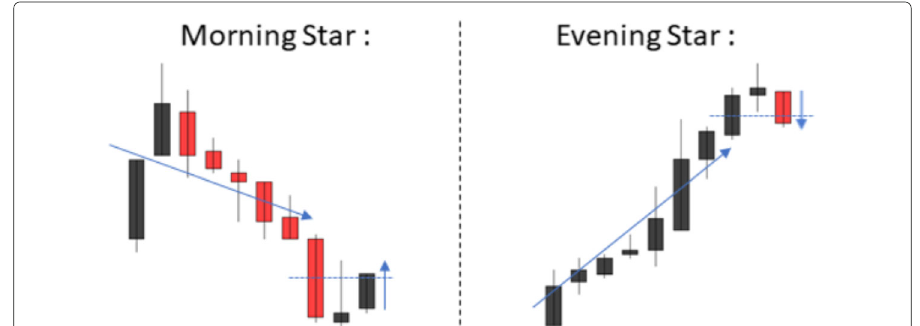
the Convolutional Neural Networks (CNN) model. In the first step, we encode time series data based on opening, high, low, and closing prices (OHLC) to GASF matrices with the window size set to 10. After this step, the shape of the data matrices will be ( 10, 10, 4 ) . In the second step, we train this 3-d matrices data with the CNN model. The architecture of our second step’s CNN model is similar to LeNet, including two convolutional layers with 16 kernels and one fully-connected layer with 128 dense. Figure 20 illustrates the entire experimental architecture, and Table 1 shows the parameters used in our GAF- CNN model.